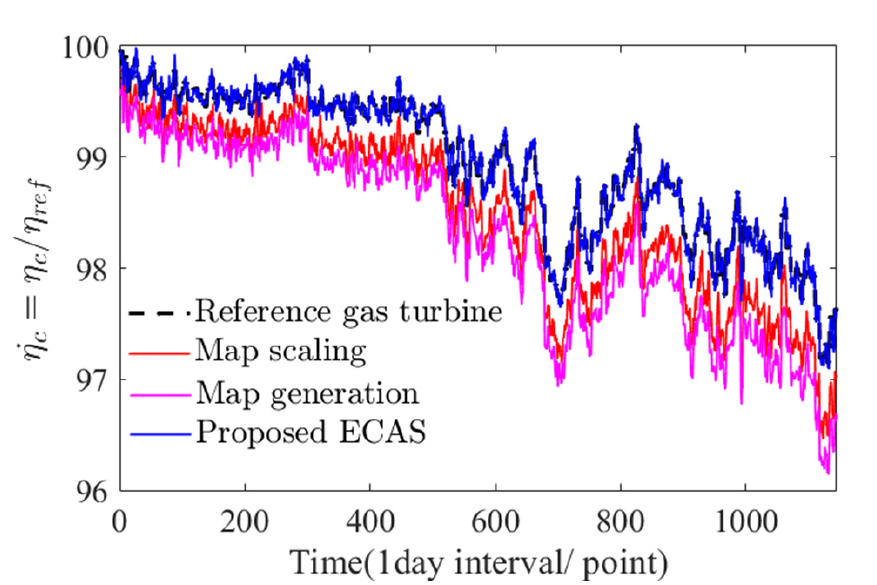
Figure 10. Normalized to design conditions percentage of the compressor efficiency before overhaul as estimated by various adaptation methods.